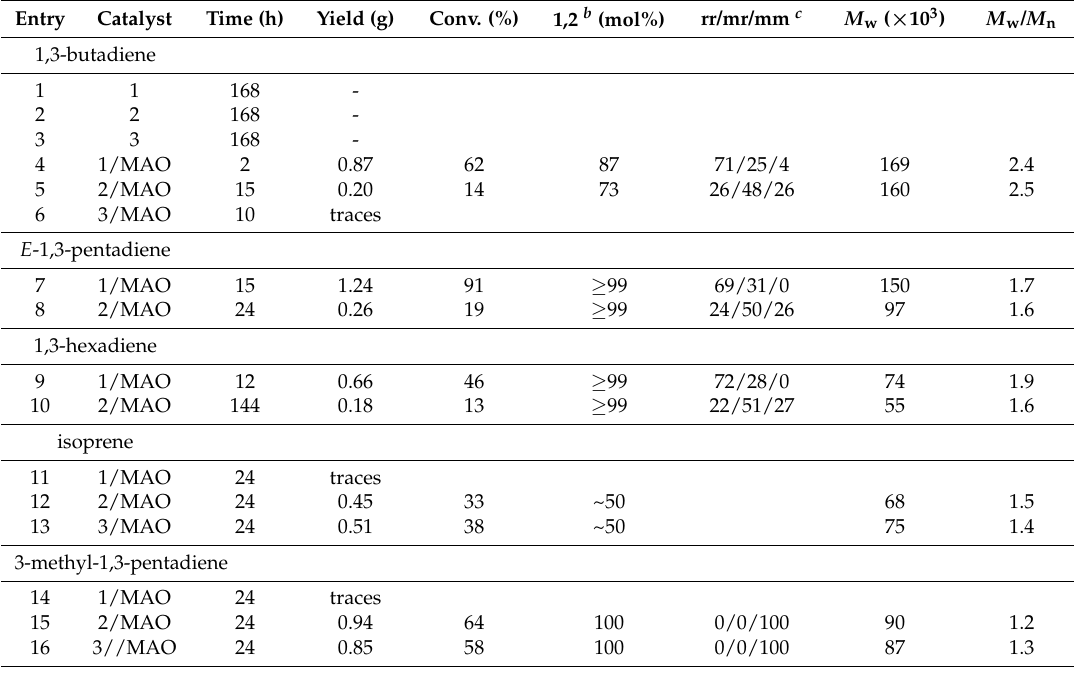
Table 4. Polymerization of 1,3-dienes with cobalt complexes 1 – 3 a